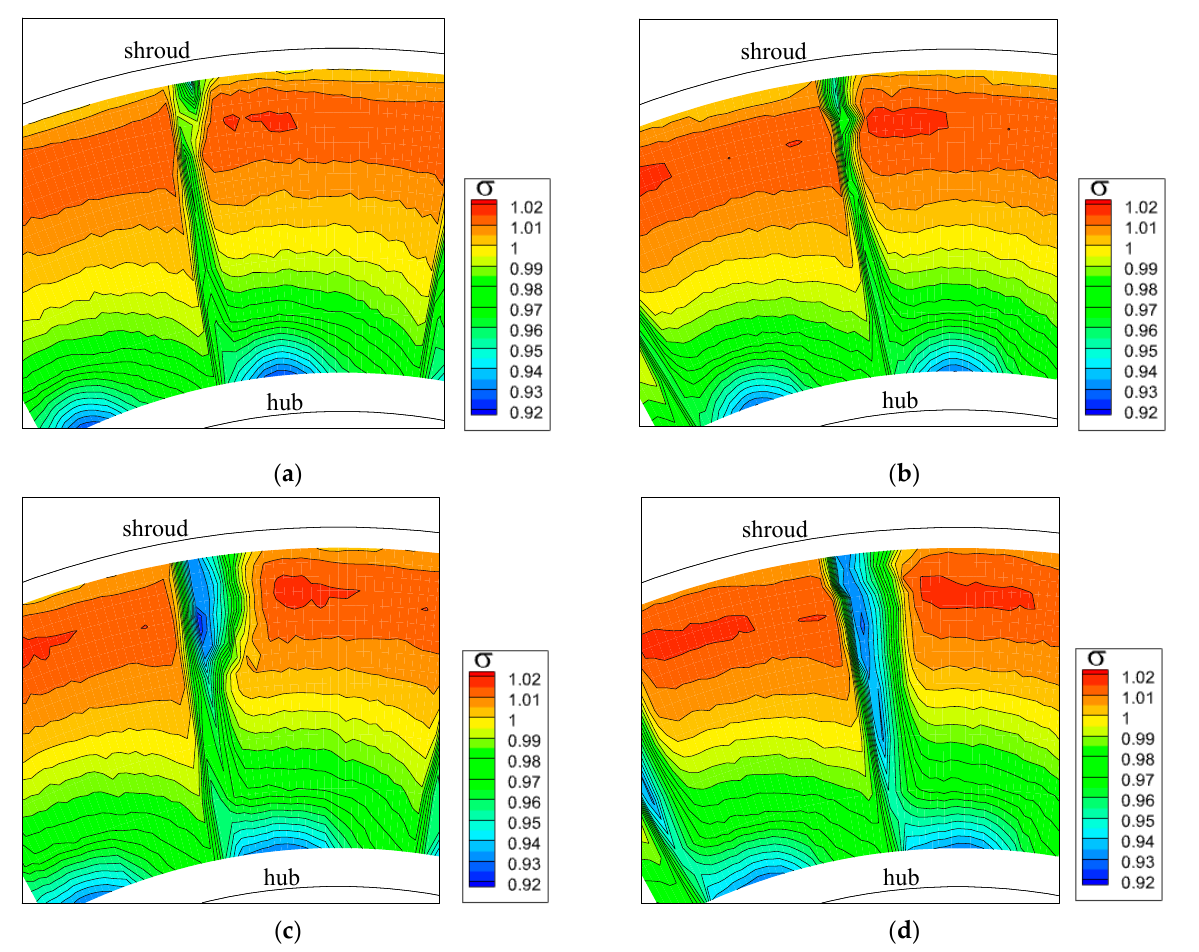
Figure 16. The two-dimensional distribution of total pressure recovery coefficient at the outlet plane of the stator: ( a ) baseline, ⎯ m = 0.89; ( b ) end wall contouring, ⎯ m = 0.89; ( c ) baseline, ⎯ m = 0.77; ( d ) end wall contouring, ⎯ m = 0.77.